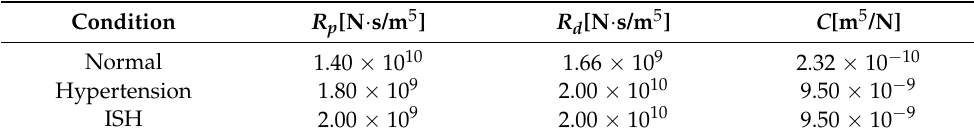
Table 3. RCR Windkessel model constants for each pressure